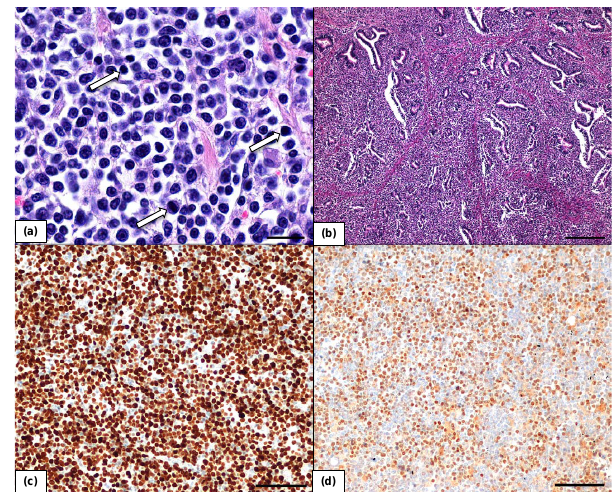
Figure 5. Light microscopic images of the urinary bladder tumor of animal 2. (a) DLBCL in the neck region of the urinary bladder composed of densely cellular sheets of medium-sized to large round cells exhibiting several mitoses (arrows) and (b) infiltrating the sem- inal vesicles. (c) Almost all tumor cells show nuclear expression of Ki67 and (d) the majority of neoplastic cells express EBNA2. HE staining ( a , d ); IHC with SABC method and chromogen DAB ( c , d ); scale bar is 20µm (a) , 200µm (b) and 100µm ( c , d ). DLBCL is diffuse large B -cell lymphoma; EBNA2 is Epstein–Barr nuclear antigen 2; IHC is immunohistochemistry; HE is hematoxylin and eosin; SABC is streptavidin–biotin complex; DAB is diaminoben- zidine